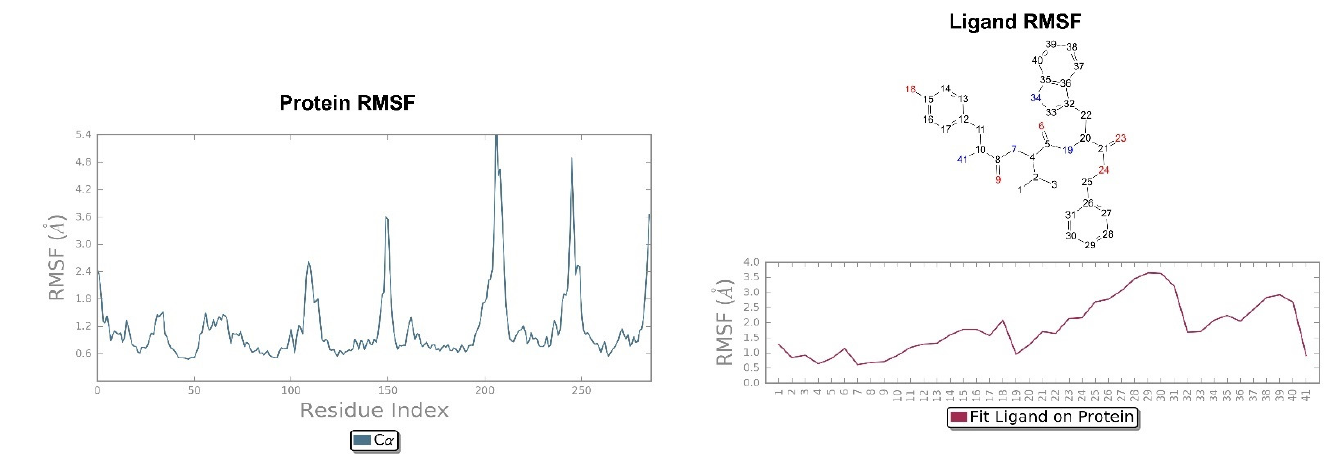
Figure 11. On the left: P-RMSF of KOR; on the right: L-RMSF of H-D-Tyr-Val-Trp-OBz ( 11 ).